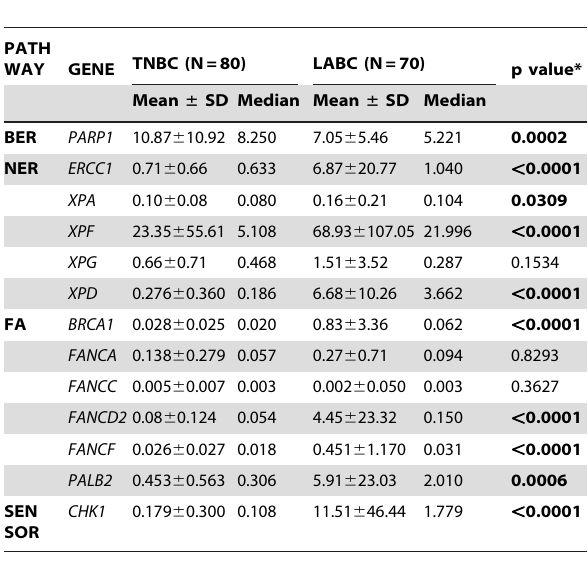
Table 3. Normalized and calibrated values (mean 6 SD and median) of the different DNA repair genes in tumor